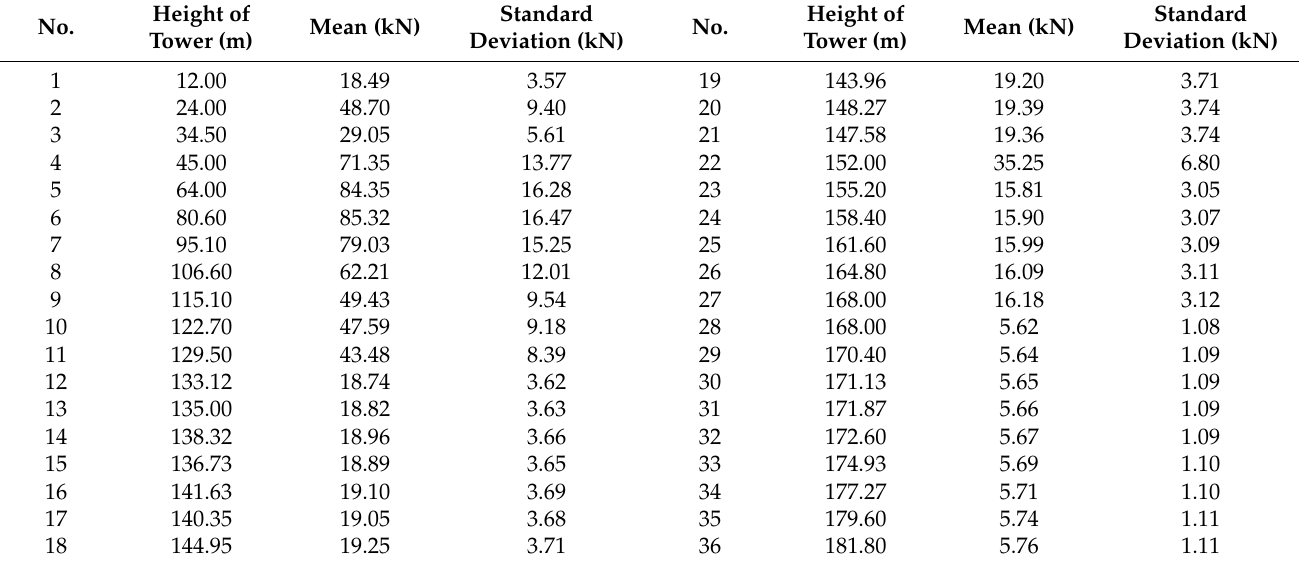
Table 2. Statistical characteristics of random equivalent static wind